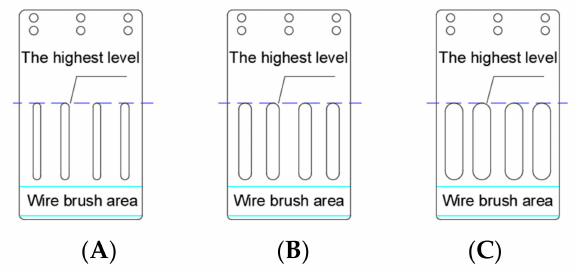
Figure 12. Three different slot area brush plates.